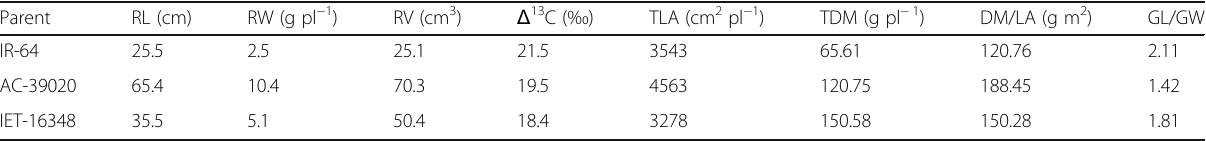
Table 2 Phenotypic variations and marker polymorphism of the trait donor genotypes in comparison with IR-64 Parent RL (cm) RW (g pl − 1 )